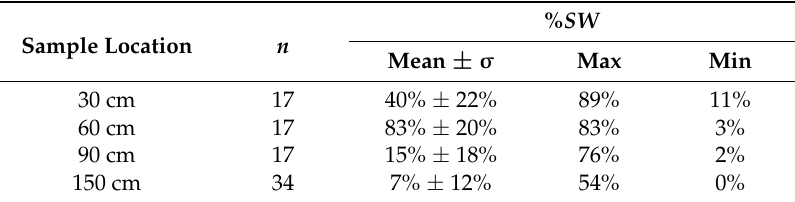
Table 2. Descriptive statistics of the calculated % SW